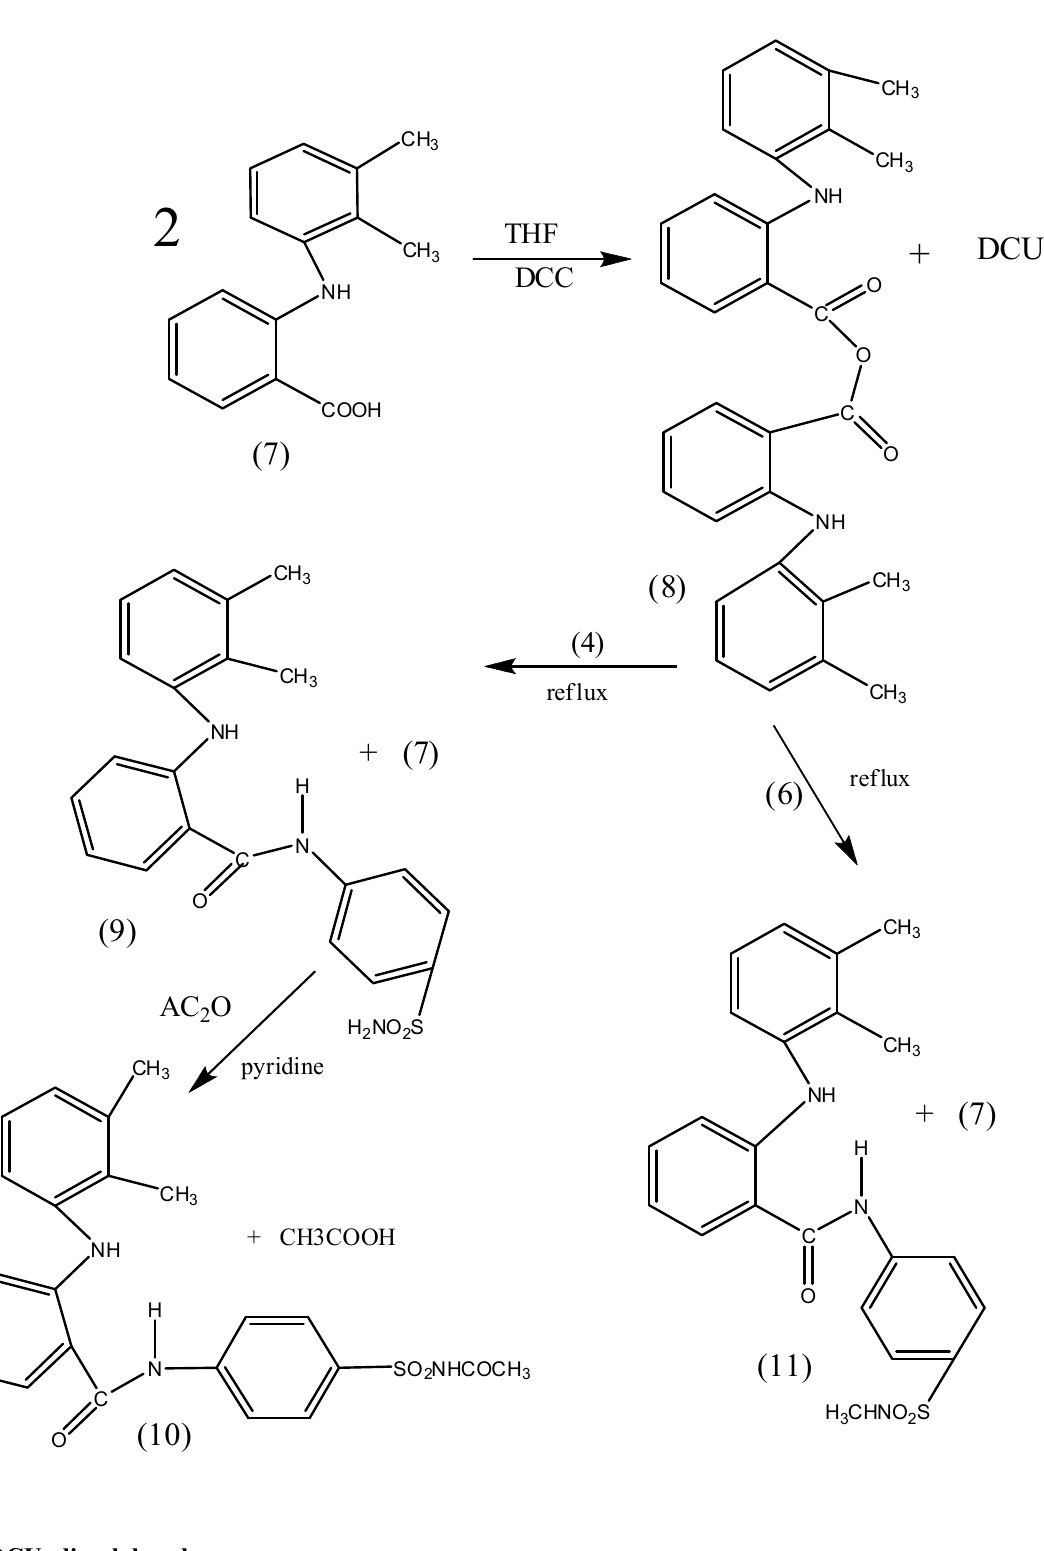
Scheme 2: Synthesis of compounds 9, 10, and